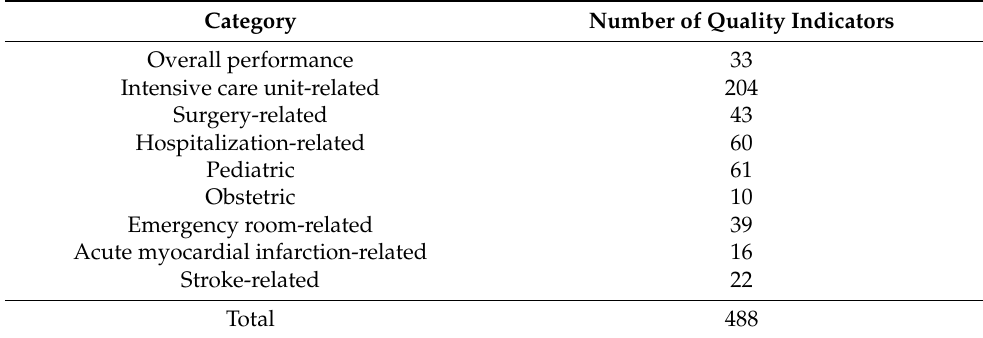
Table 1. Categories and numbers of quality indicators in TCPI